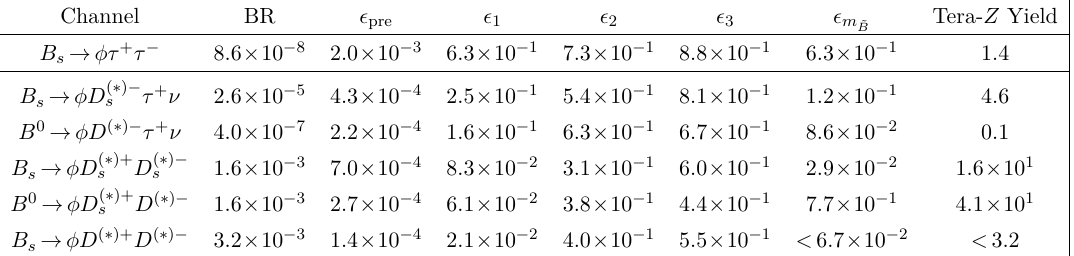
Table 12 . Detailed cut flows and Tera- Z yields for the B s → φτ + τ − measurement. (cid:15) denotes the efficiency for each cut defined in the